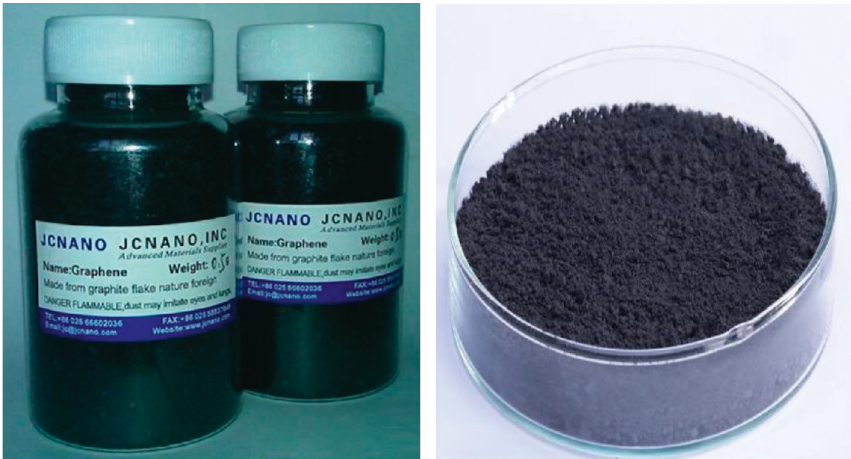
Figure 1: Selected graphene oxide. Table 1: Technical indices of selected GO.